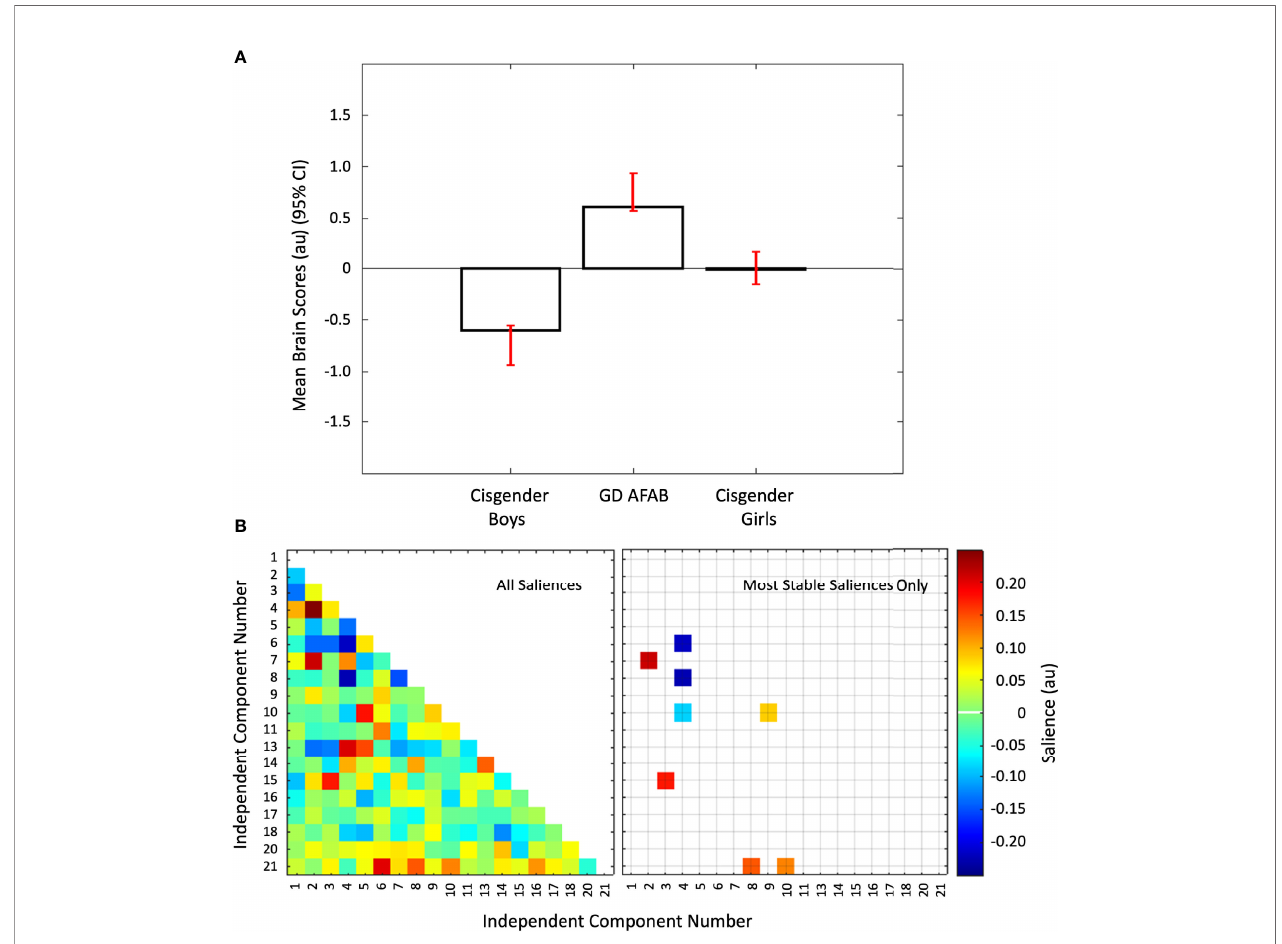
FIGURE 3 | Group differences in inter-network functional connectivity. Panel (A) Mean brain scores (± 95% con fi dence interval, CI) from the fi rst PLS analysis showing group differences: cisgender girls were intermediate between cisgender boys and GD AFAB (gender dysphoria, assigned female at birth). Scatterplots of brain scores by design scores for all participants are shown in Figure S1 ( Supplementary Material ). Panel (B) Heat maps of the brain saliences for the 19 independent component (IC) pairs (left) and the eight IC pairs with the most stable saliences (right). The z-scored correlations within each group for the eight most stable IC pairs are displayed in Figure S4 ( Supplementary Material ). ICs 12, 19, and 22-25 were discarded as noise or non-gray matter signal. Network names are in Table 1